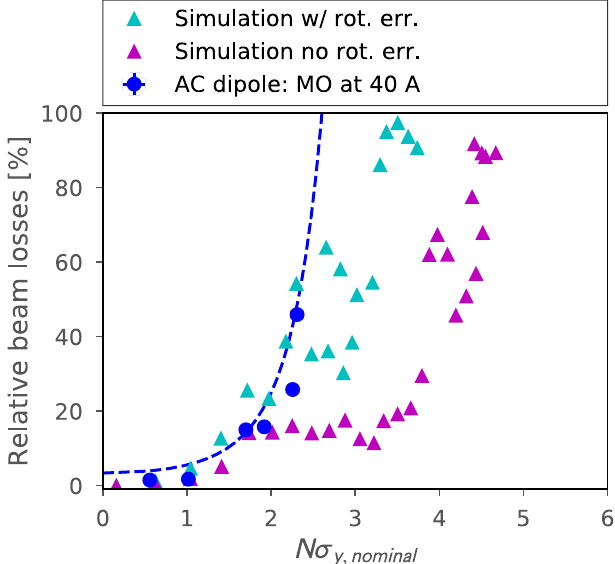
blue.FIG. 18. Measured losses for ac dipole excitations with Landau octupoles at 40 A from measurements and multiparticle simu- lations. The simulations results without geometrical rotational lattice errors are shown in pink, while the simulations including those rotational errors are shown in light